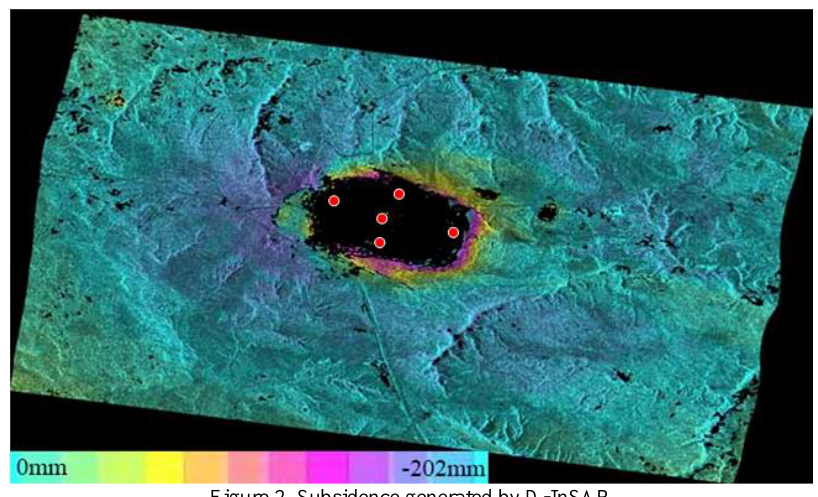
Figure 2. Subsidence generated by D-InSAR